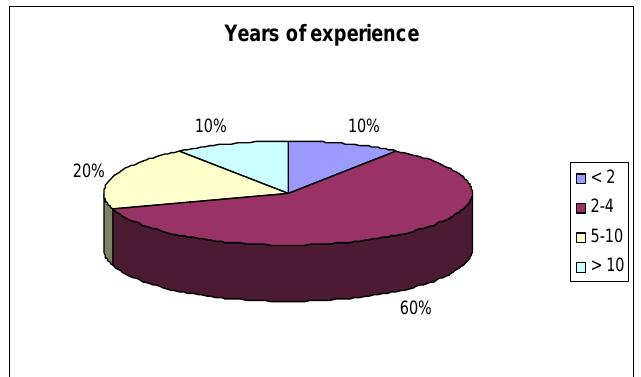
Figure 2: Respondents’ years of experience in Chinese